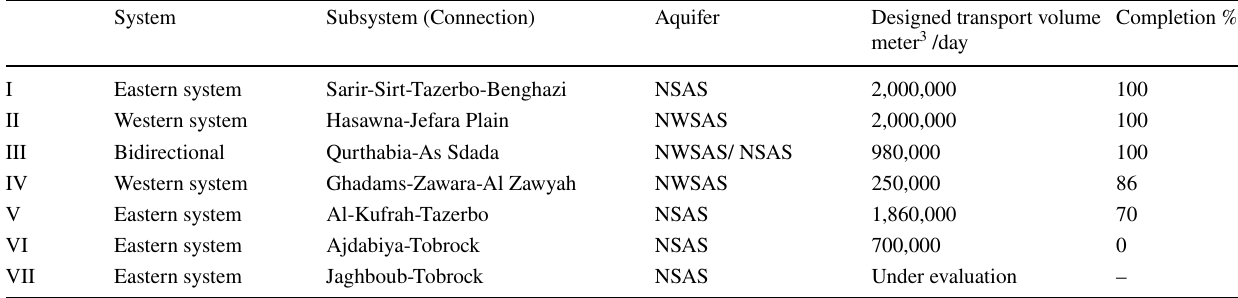
Fig. 1 Map of Libya transboundary aquifers and the main water conveyance systems and connections of MMR (map based on data from (GWA 2006; IGRAC and UNESCO 2016) Table 1 Main water conveyance systems and connections of MMR (GWA 2006; MMRA